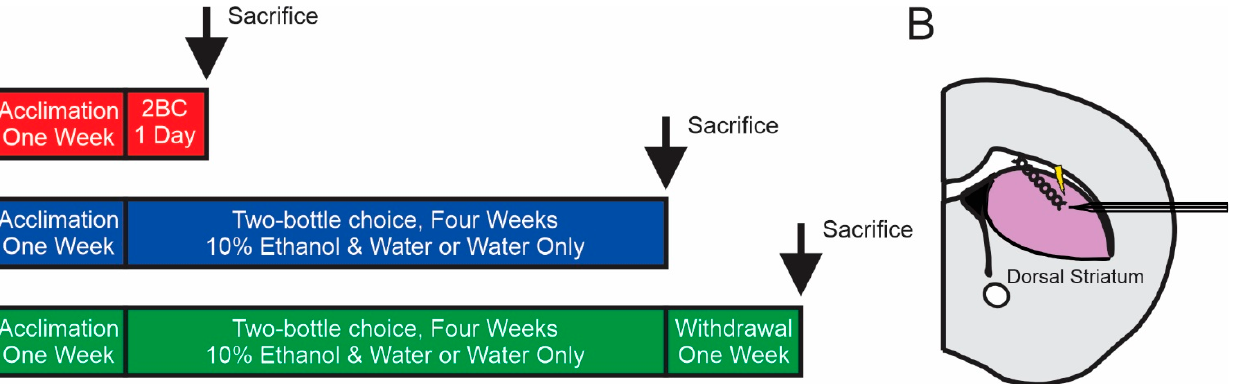
Figure 1. Schematic illustrating the experimental timeline ( A ) and fast-scan cyclic voltammetry recording area ( B ).